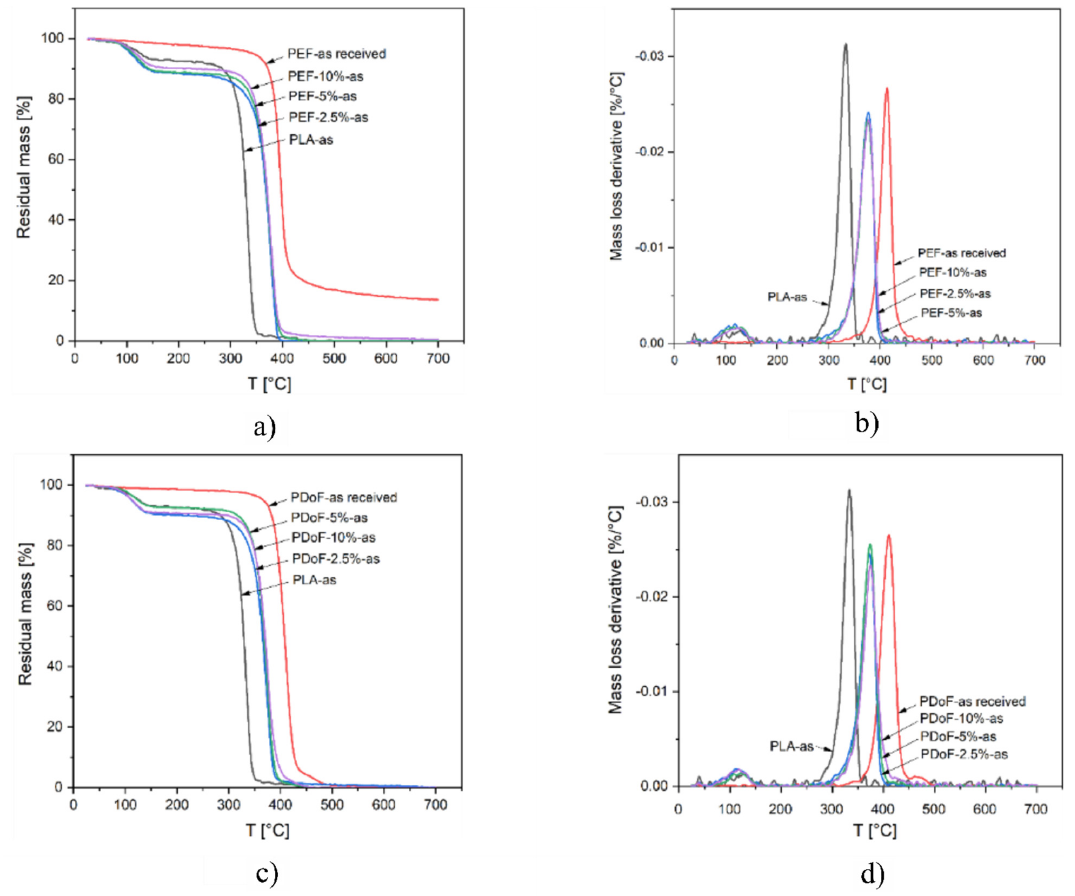
Figure 8. TGA thermograms: ( a ) residual mass and ( b ) mass loss derivative of the PLA − as, PEF − 2.5% − as, PEF − 5% − as, PEF − 10% − as, and PEF − as received samples; ( c ) residual mass, and ( d ) mass loss derivative of PLA − as, PDoF − 2.5% − as, PDoF − 5% − as, PDoF − 10% − as, and bulk PDoF − as received samples. Table 5. TGA results for the PLA − as, PEF − 2.5% − as, PEF − 5% − as, PEF − 10% − as bulk PEF − as received